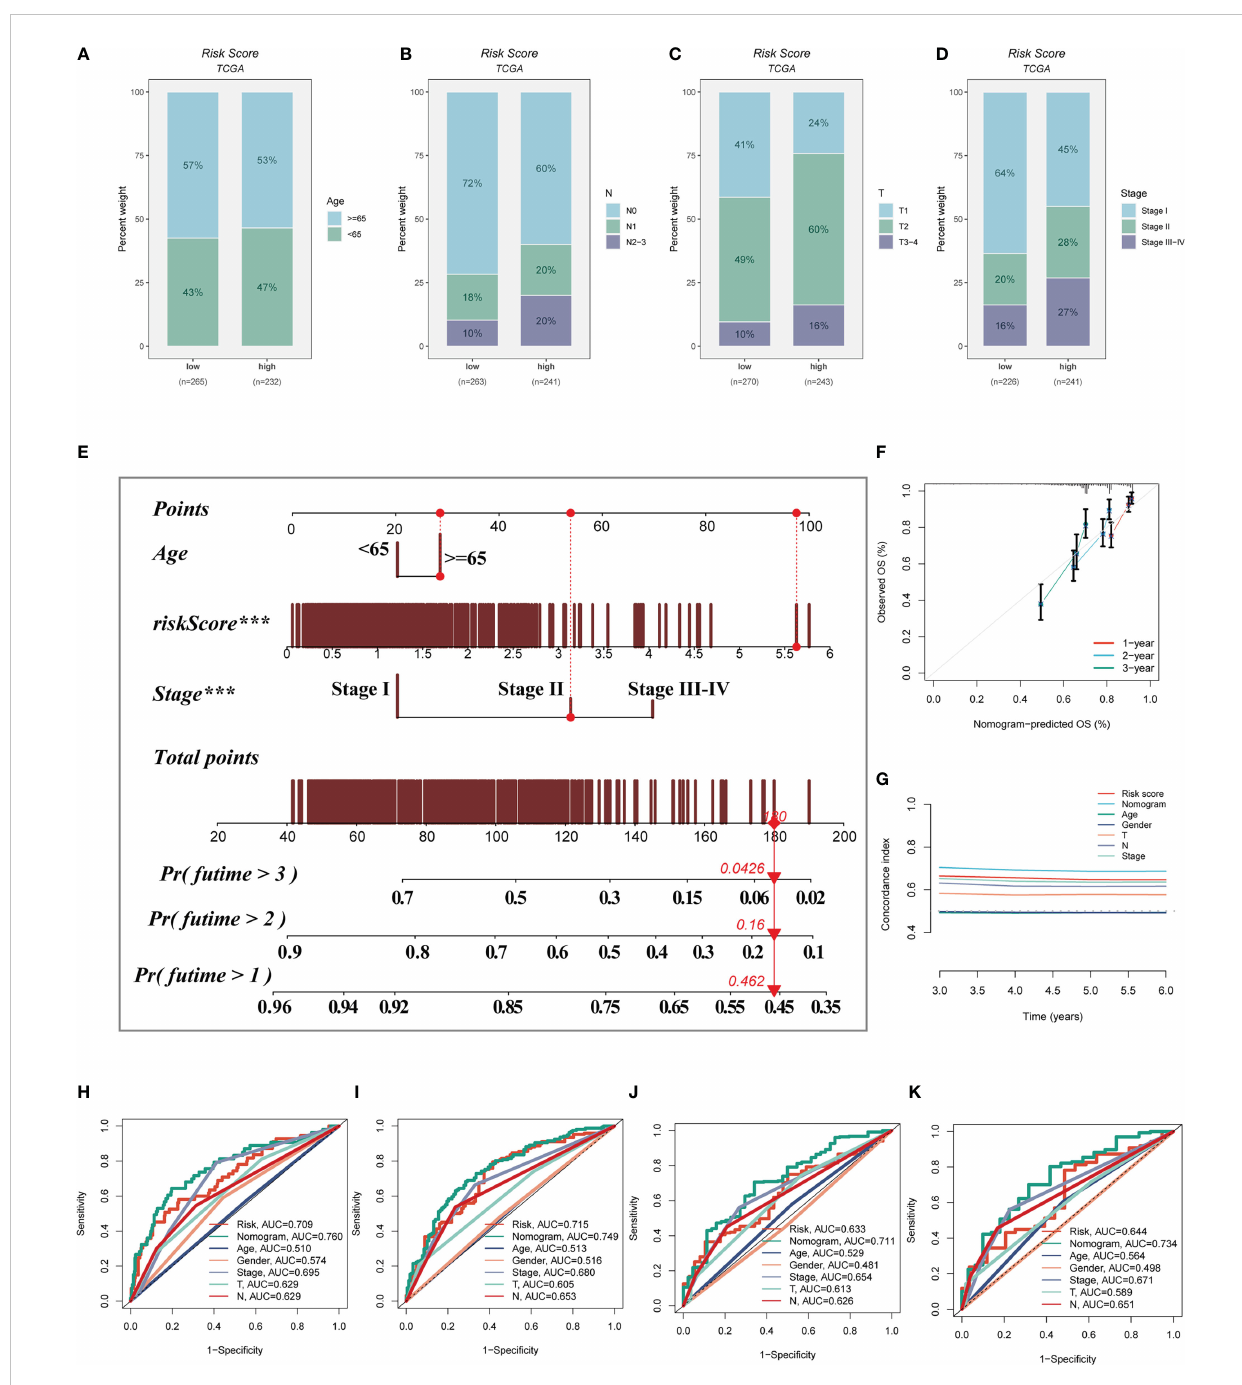
FIGURE 6 Building a more accurate nomogram. (A-D) The proportion of clinical characters (age, N stage, T stage, and clinical stage) in different risk groups. (E) Nomogram was constructed by combining clinical features with risk score. (F) The calibration plots test consistency between the actual OS rates and the predicted survival rates, with the 45°line representing the best prediction. (G) The C-index curves were used to evaluate the predictive performance of different clinical characteristics, nomogram scores and risk scores. (H-K) ROC curves for 1, 3, 5, and 7 years showed AUC values for various clinical factors, risk scores, and nomogram